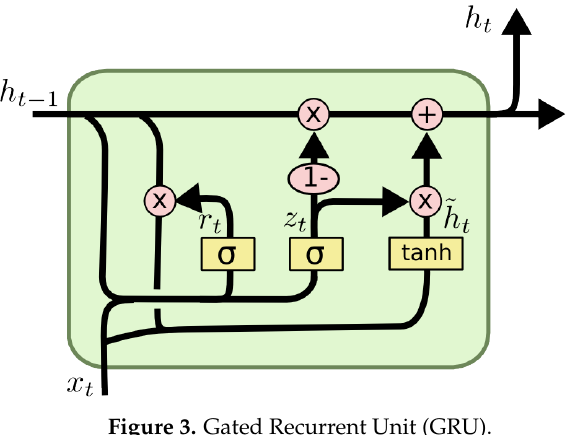
Figure 3. Gated Recurrent Unit